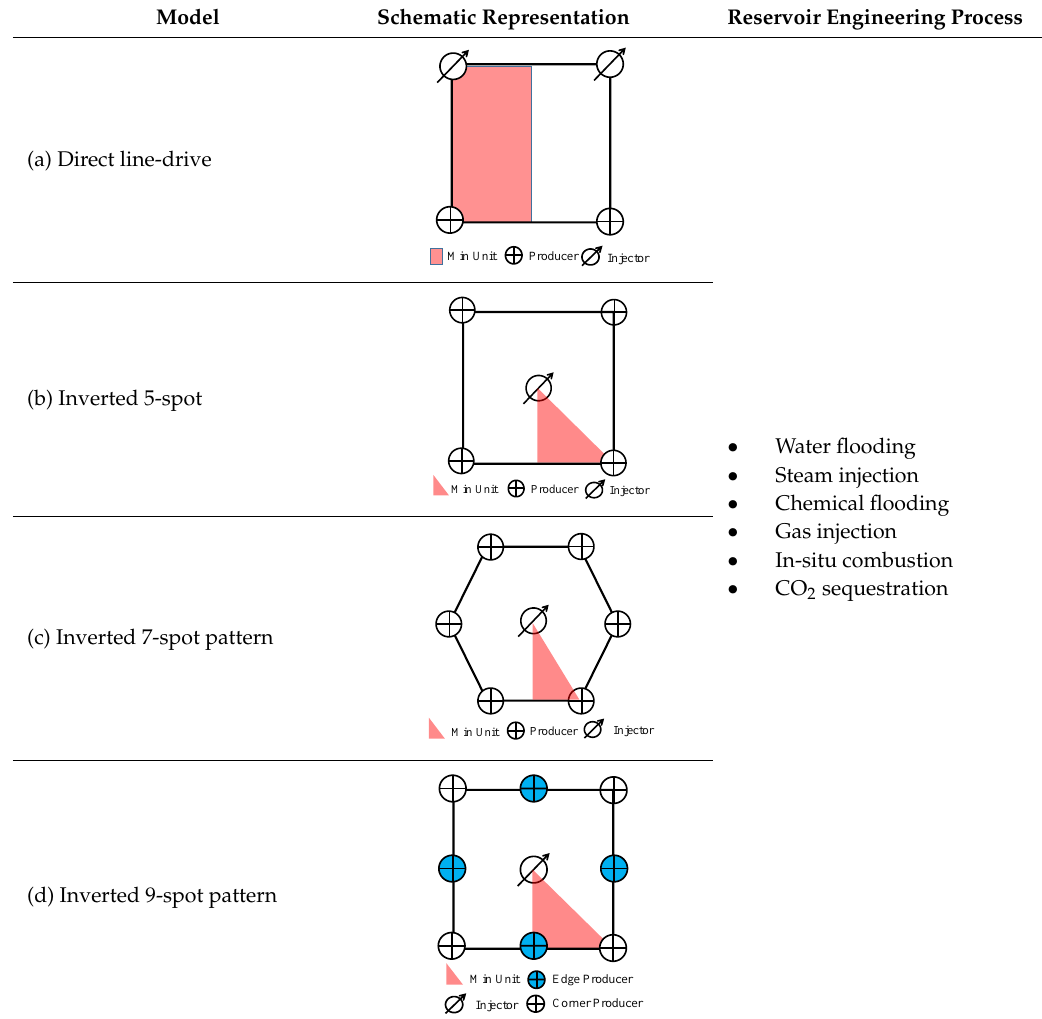
Table 3. Injection-pattern-scale models *.